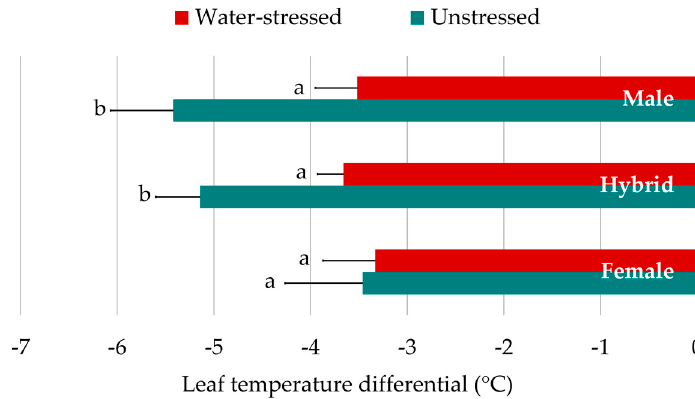
Figure 3. Di ff erences in leaf temperature di ff erential response to water conditions between genotypic Figure 3. Differences in leaf temperature differential response to water conditions between genotypic sets (all hybrids combined). Means ± 95% confidence interval of LTD in ◦ C are represented for sets (all hybrids combined). Means ± 95% confidence interval of LTD in °C are represented for each each genotypic class, under water-stressed and unstressed conditions. Bars with di ff erent letter are genotypic class, under water ‐ stressed and unstressed conditions. Bars with different letter are significantly di ff erent at P < 0.05 according to means separation by LSD. significantly different at P < 0.05 according to means separation by LSD.